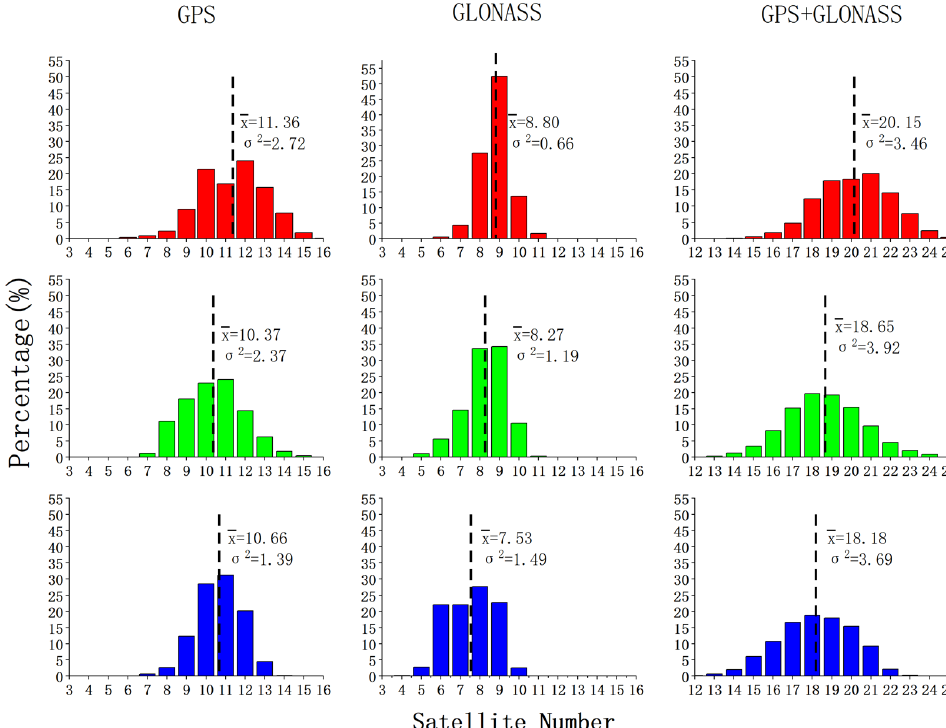
Figure 5. The histogram of visible satellites in the high (red), middle (green), and low (blue) latitude networks. The position of the dashed line and the value x − indicate the average number of visible satellites. The σ 2 represents the variance of the visible satellites’ distribution. Please note that the horizontal axis of GPS and GLONASS visible satellites differs from that of GPS+GLONASS.